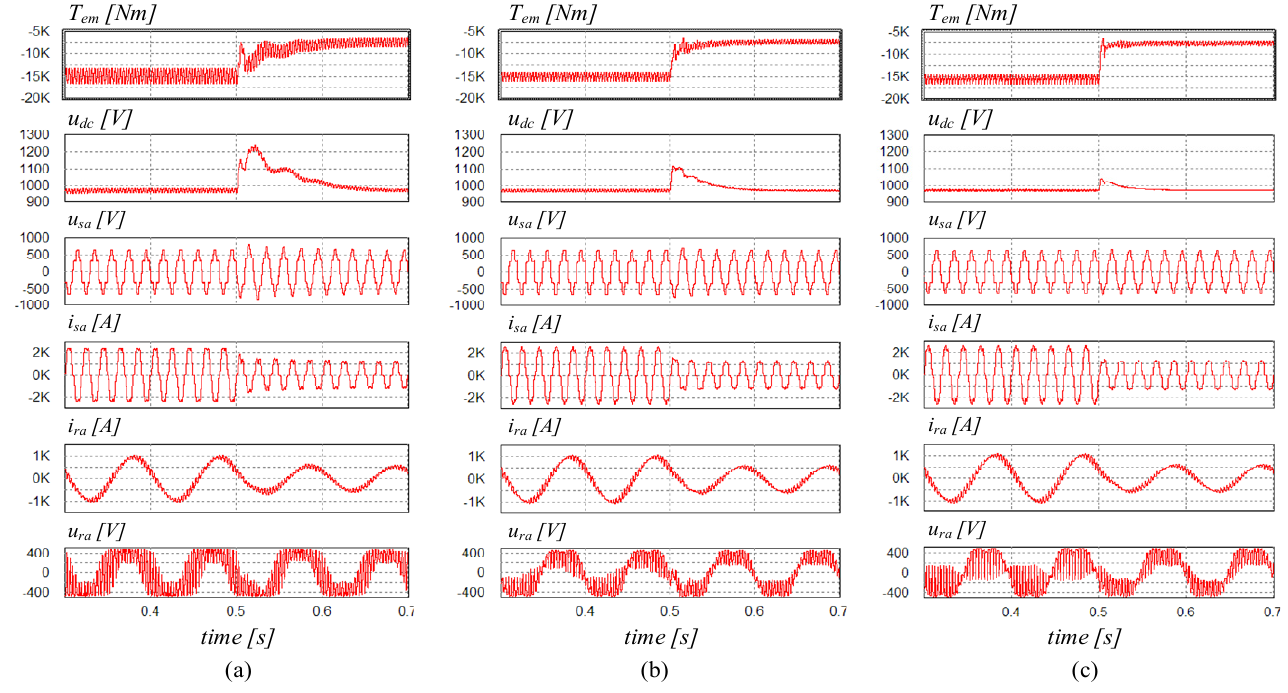
Figure 7. Simulation results of a 2 MW DFIG-DC system at 1200 rpm for field-oriented control FOC ( a ), direct torque and flux module control DT Ψ C ( b ), and the proposed direct torque and x variable control DTXC ( c ) with limited rotor voltage during transient.